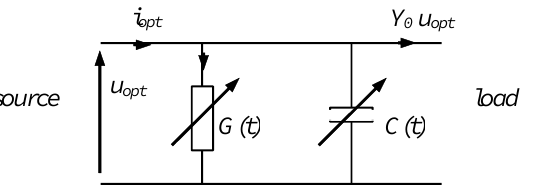
Figure 1. The parametric, conductance-capacitive model of the compensation circuit.